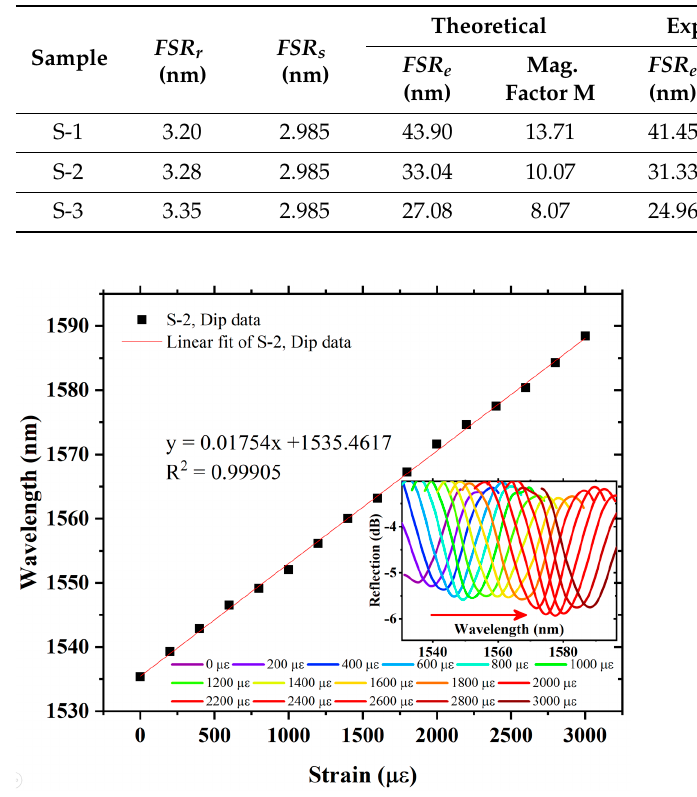
Figure 10. Sensitivity and linear correlation function of S-2, and inset exhibits spectral evolution of envelope dip data.